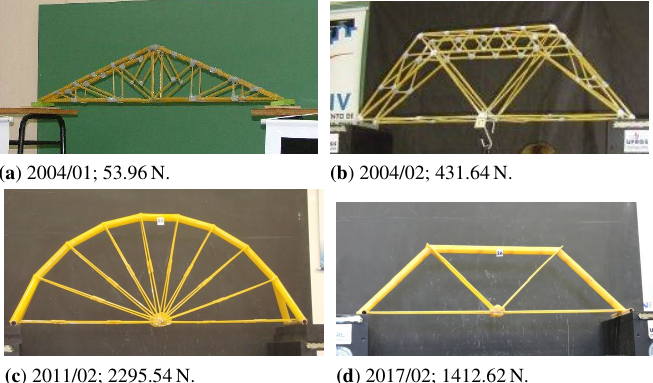
Figure 9. A few winning designs for the UFRGS Spaghetti Bridge contest, data from [42].